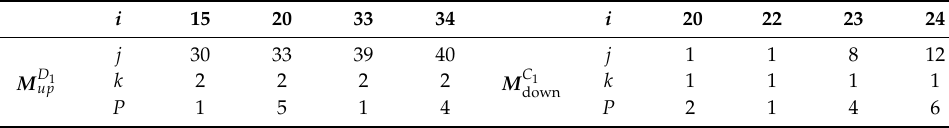
Table 8. Scheduling tasks of Elevator-CD in the second half cycle.